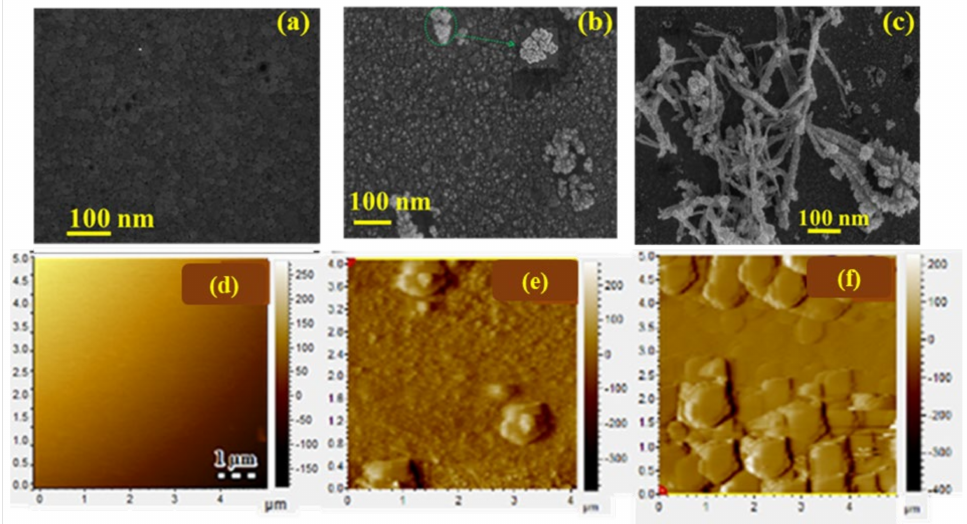
Figure 3. ( a – c ) SEM and ( d – f ) 2D AFM micrographs recorded for Pd ( a , d ), Pd 3 Te 1 ( b , e ), and Pd 2 Te 2 ( e , f )